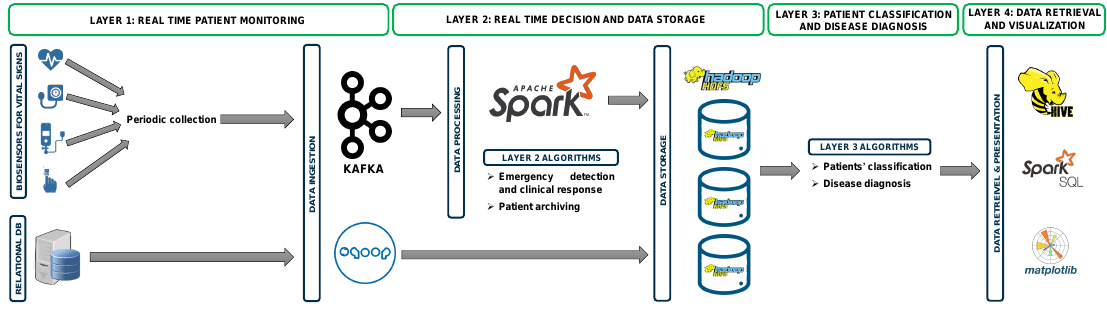
Figure 1. Architecture of our